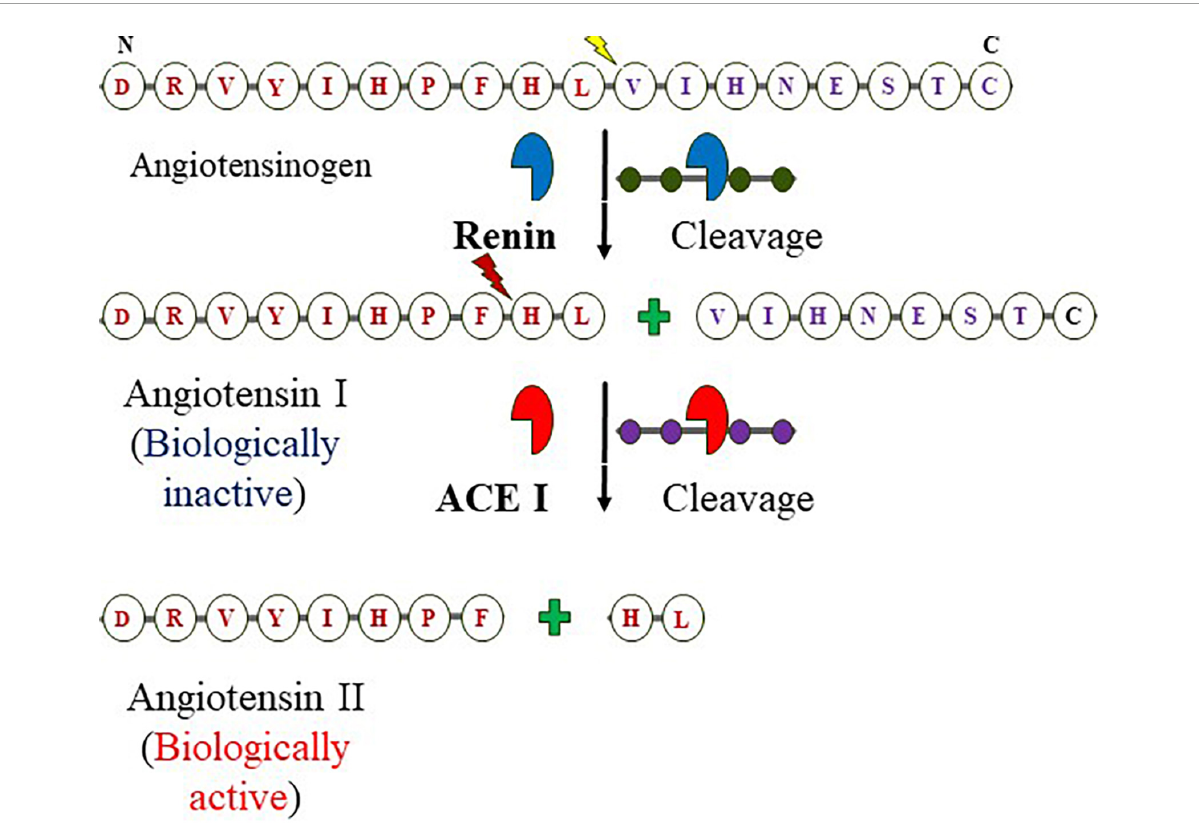
FIGURE1 Components of RAAS and formation of angiotensin II from angiotensinogen: The enzymatic reaction cleaves off N-terminal of angiotensinogen by the kidney-derived enzyme renin at Leucine–Valine to form angiotensin I (decapeptide) which is in turn digested by the endothelium-bound angiotensin-converting enzyme (ACE I) at Phenylalanine-Histidine yields the